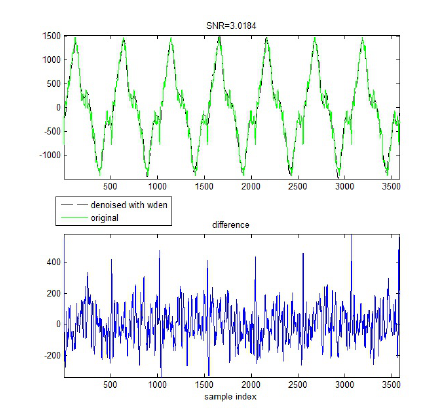
Figure 6. Metrics for WPT-based denoising of steady signals. Left figures –MAD. Right fig- ures – RMSD. Top – for all elements. Bottom, without 3 elements nearby each edge.